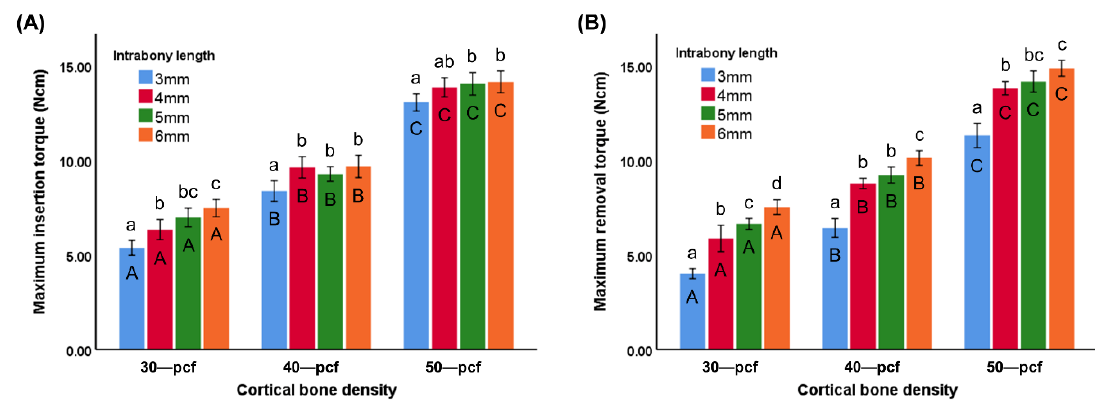
Figure 5. ( A ) Maximum insertion torque (MIT) and ( B ) maximum removal torque (MRT) of the miniscrews at various intrabony lengths in cortical bone of different densities. Different uppercase letters indicate a significant difference between the miniscrews inserted into cortical bone of various densities ( p < 0.05), while different lowercase letters indicate a significant difference between the miniscrews at the various intrabony lengths ( p < 0.05).